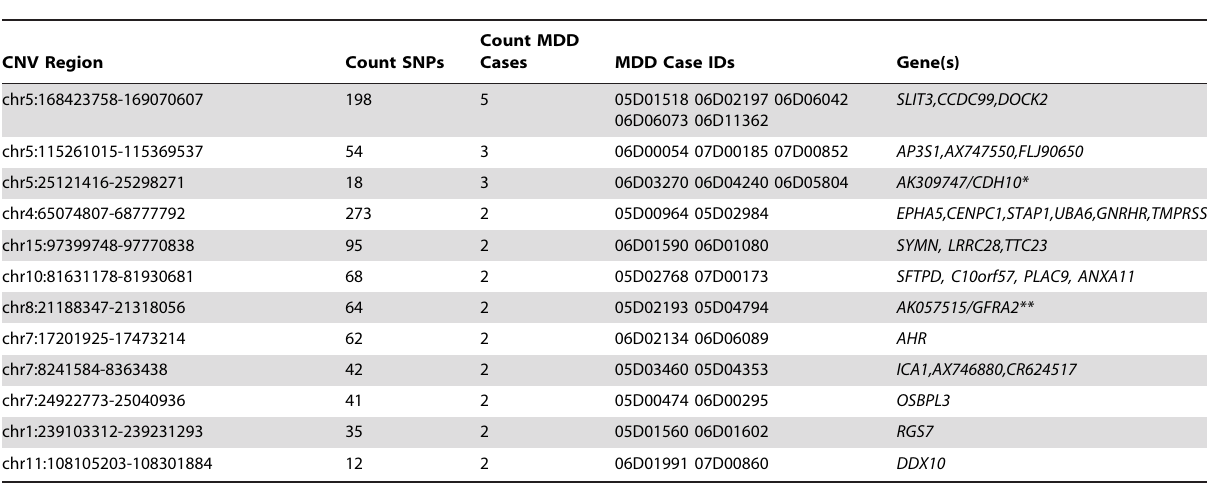
Table 1. All associated CNV regions recurrent in MDD